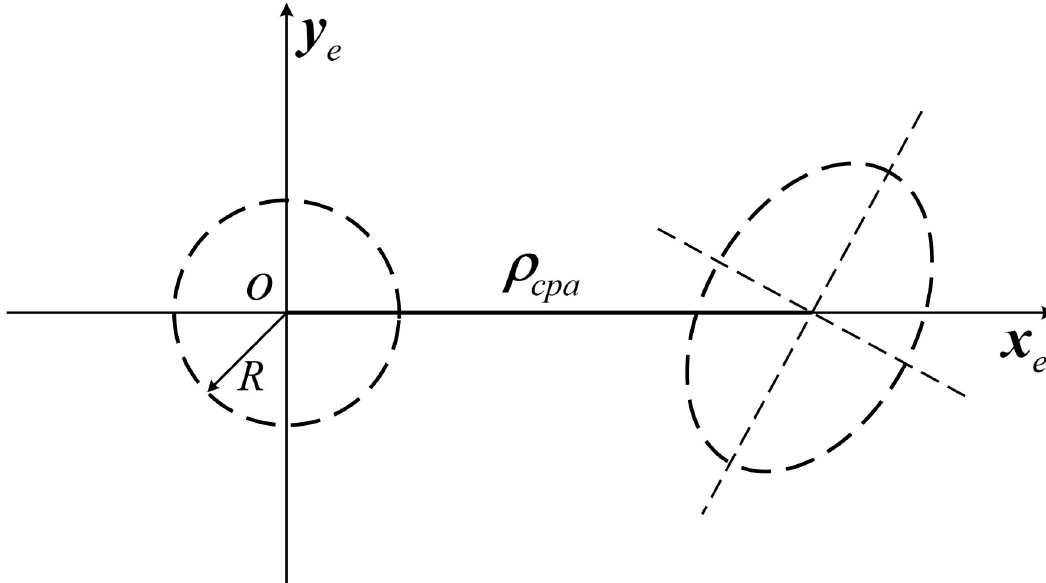
Fig 7. Joint circle domain and joint error